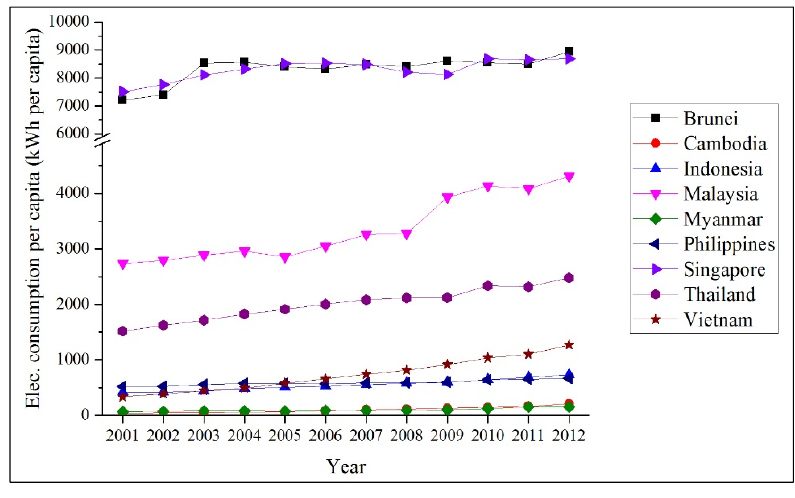
Figure 27. Electricity consumption per